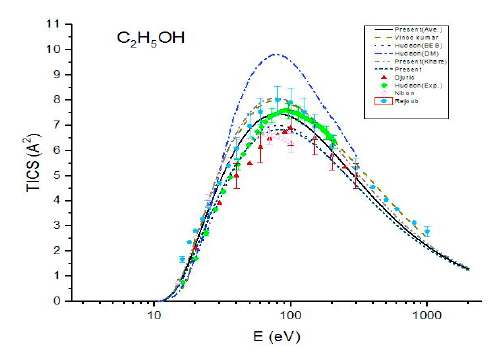
Figure 2. Total ionization cross sections (TICS) for C 2 H 5 OH in A 2 , the solid line represents the present (Ave.) results, the dash line represents the theoretical results measured by Vinodkumar et al. [8], the dash dot line represents the theoretical results measured by Hudson et al. [9] using DM formulism, the dot line represents the BEB calculations by Hudson et al. [9], the dash dot dot line represents the present (Khare BEB), the short dash line represents the present results. Filled triangles, filled squares, open circles and filled pentagons are the experimental results of Djuric et al. [11], Hudson et al. [9], Nixon et al. [6] and Rejoub et al. [12], respectively.